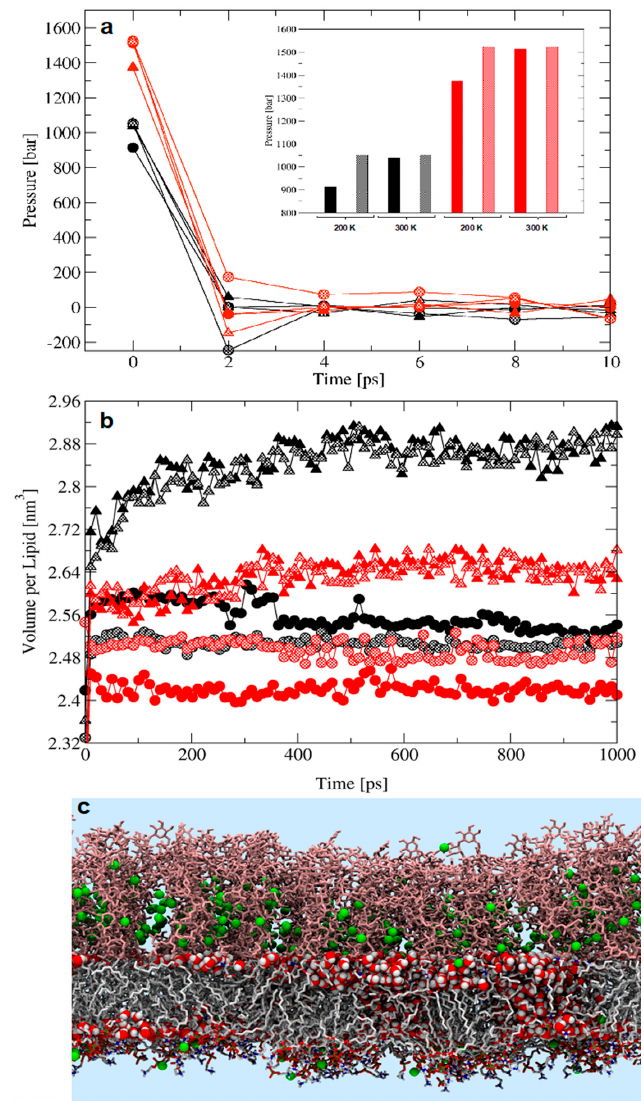
Figure 1. The effect of temperature, barostat coupling constant, and long-range electrostatic treatment on the ( a ) initial pressure and ( b ) V L for lipopolysaccharide (LPS)/DPPE bilayers equilibrated under NVT/NPT conditions. The two long-range electrostatics approximations are shown in black (PME) and red (RF). The barostat coupling constants are represented by filled (0.1 ps) or dotted (1.0 ps) symbols and bars. Simulations performed at 200 K and 300 K are shown in circles and triangles, respectively. The inset shows pressure averages at the first step of the NPT phase for direct comparison. ( c ) Representative configuration of the LPS/DPPE bilayer with the largest value of volume per lipid (dotted black triangles). Only water molecules inside the hydrophobic region of the membrane are shown and near clipping of LPS molecules was applied to improve visualization. Ca 2+